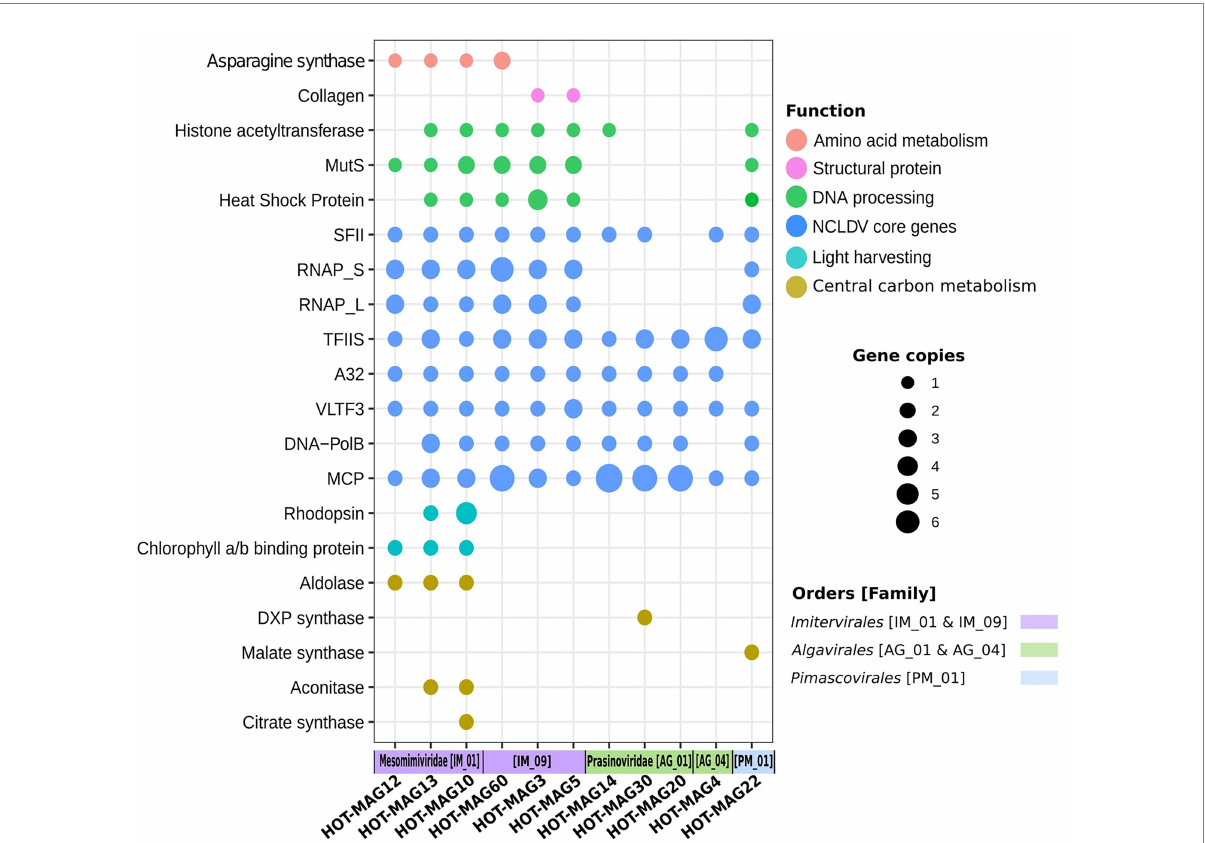
FIGURE 7 Distribution of selected genes within 11 MAGs of giant viruses. The x-axis indicates the 11 MAGs of giant viruses together with the viral families and orders that they belong to. The size of the bubbles indicate the total abundance of the genes within the genomes of 11 MAGs. the abbreviations of the encoded genes are as follows: MutS: mismatch DNA repair, RNAP: DNA-dependent RNA polymerase Large and Small subunits, SFII: superfamily II helicase, TFIIB: transcription factor IIB, A32: A32 ATPase, VLTF: viral late transcription factor 3, MCP: major capsid protein, DXP synthase: 1-Deoxy-D-xylulose 5-phosphate